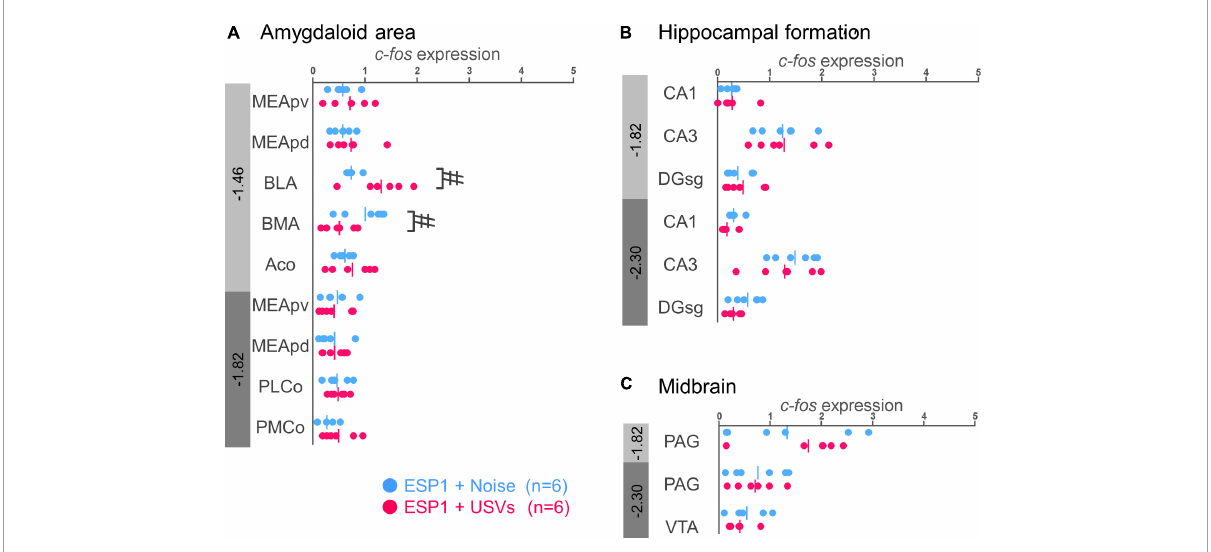
FIGURE4 Expression levels of c-fos mRNA in the amygdala (A) , hippocampus (B) , and midbrain (C) of female mice. Blue and red symbols represent individual data for (exocrine gland-secreting peptide 1) ESP1+noise and ESP1+USVs (ultrasonic vocalizations) conditions, respectively. Vertical lines indicate mean values. Numbers in gray bands indicate approximate anteroposterior distance to the bregma (mm). # p < 0.05 (Welch’s t -test; but not significant after multiple comparisons correction). MEApv, medial amygdaloid nucleus, posteroventral part; MEApd, medial amygdaloid nucleus, posterodorsal part; BLA, basolateral amygdaloid nucleus; BMA, basomedial amygdaloid nucleus; Aco, anterior cortical amygdaloid area; PLCo, posterolateral cortical amygdaloid area; PMCo, posteromedial cortical amygdaloid area; CA1, field CA1 of the hippocampus; CA3, field CA3 of the hippocampus; DG-sg, dentate gyrus, granule cell layer; PAG, periaqueductal gray; VTA, ventral tegmental area.